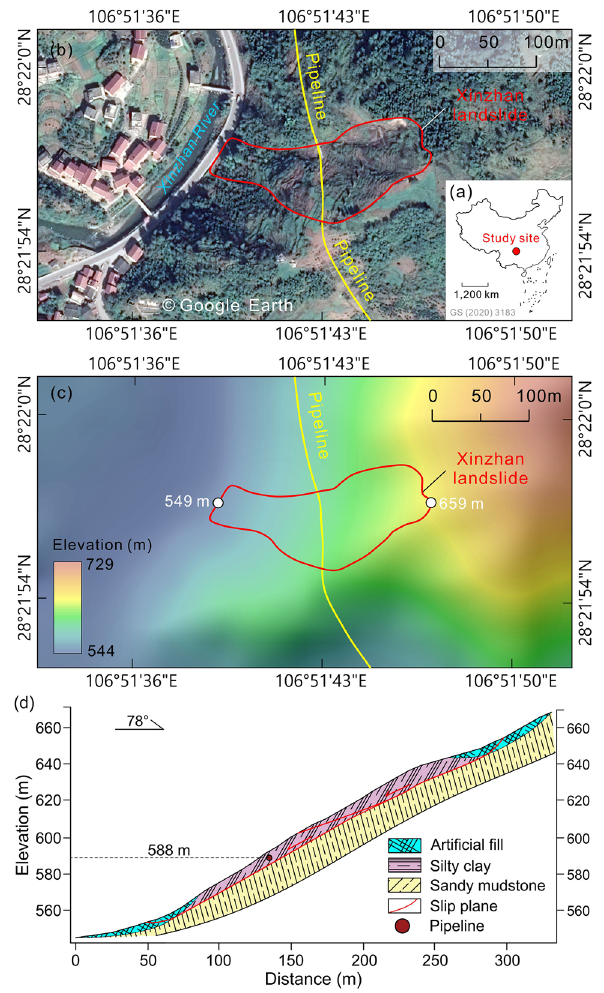
Fig. 1 a Location of the study area in Tongzi County, Zunyi City, Guizhou Province, China; b Location of the 2015 Xinzhan landslide, Guizhou, China; c Xinzhan landslide elevation range (549−659 m); d Geological profile of the Xinzhan